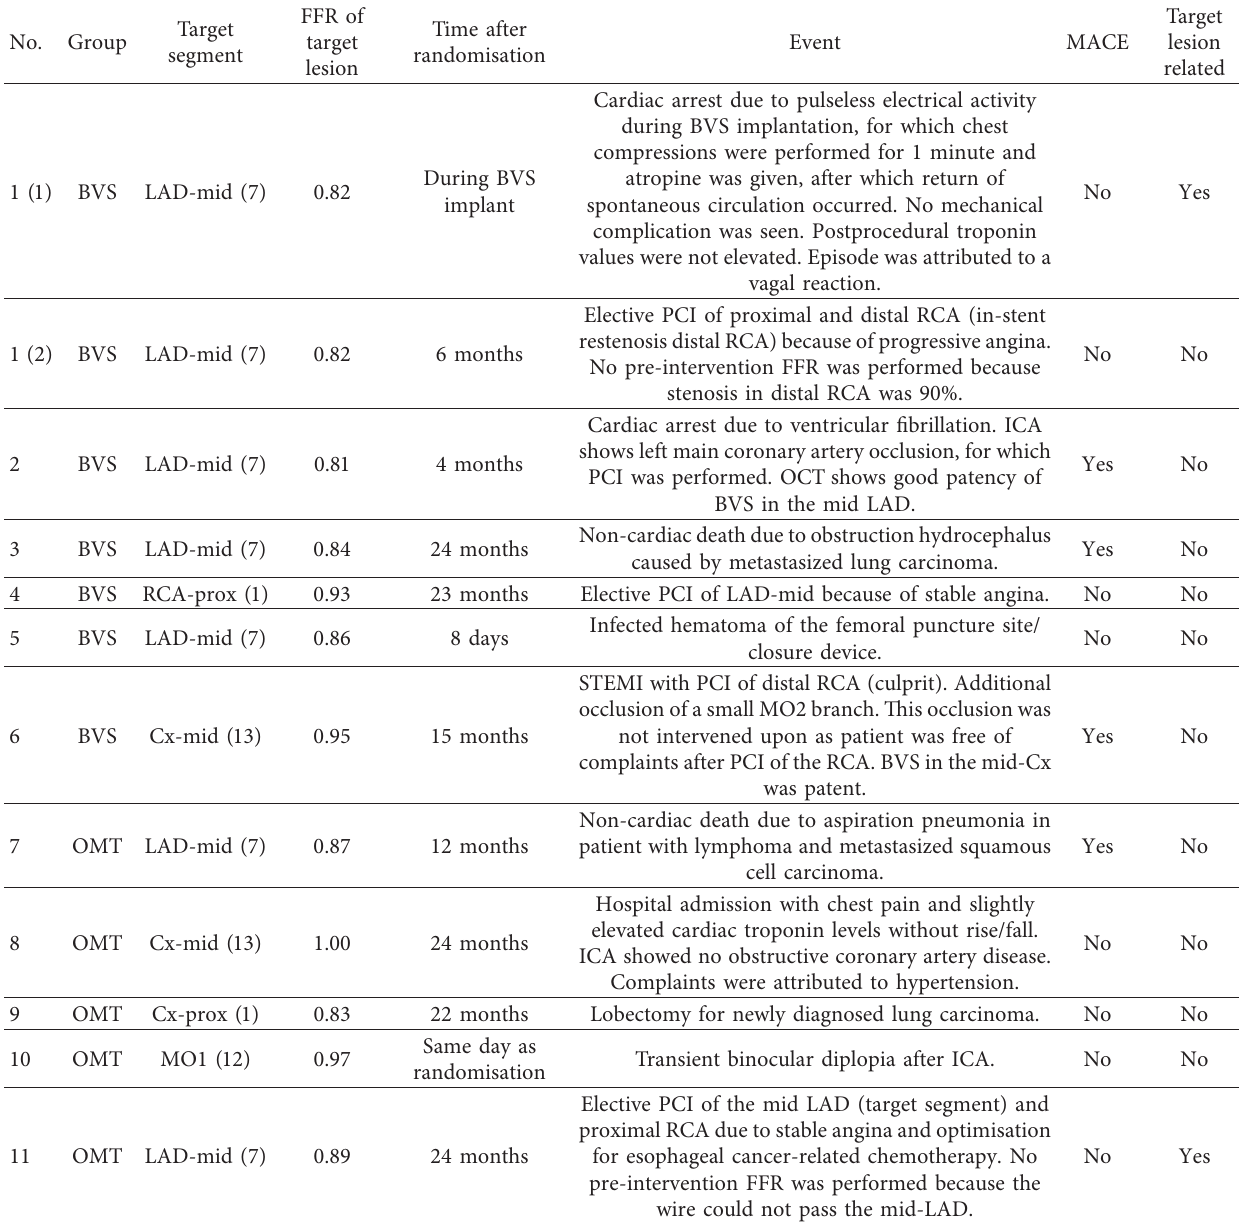
Table 4: Clinical events.